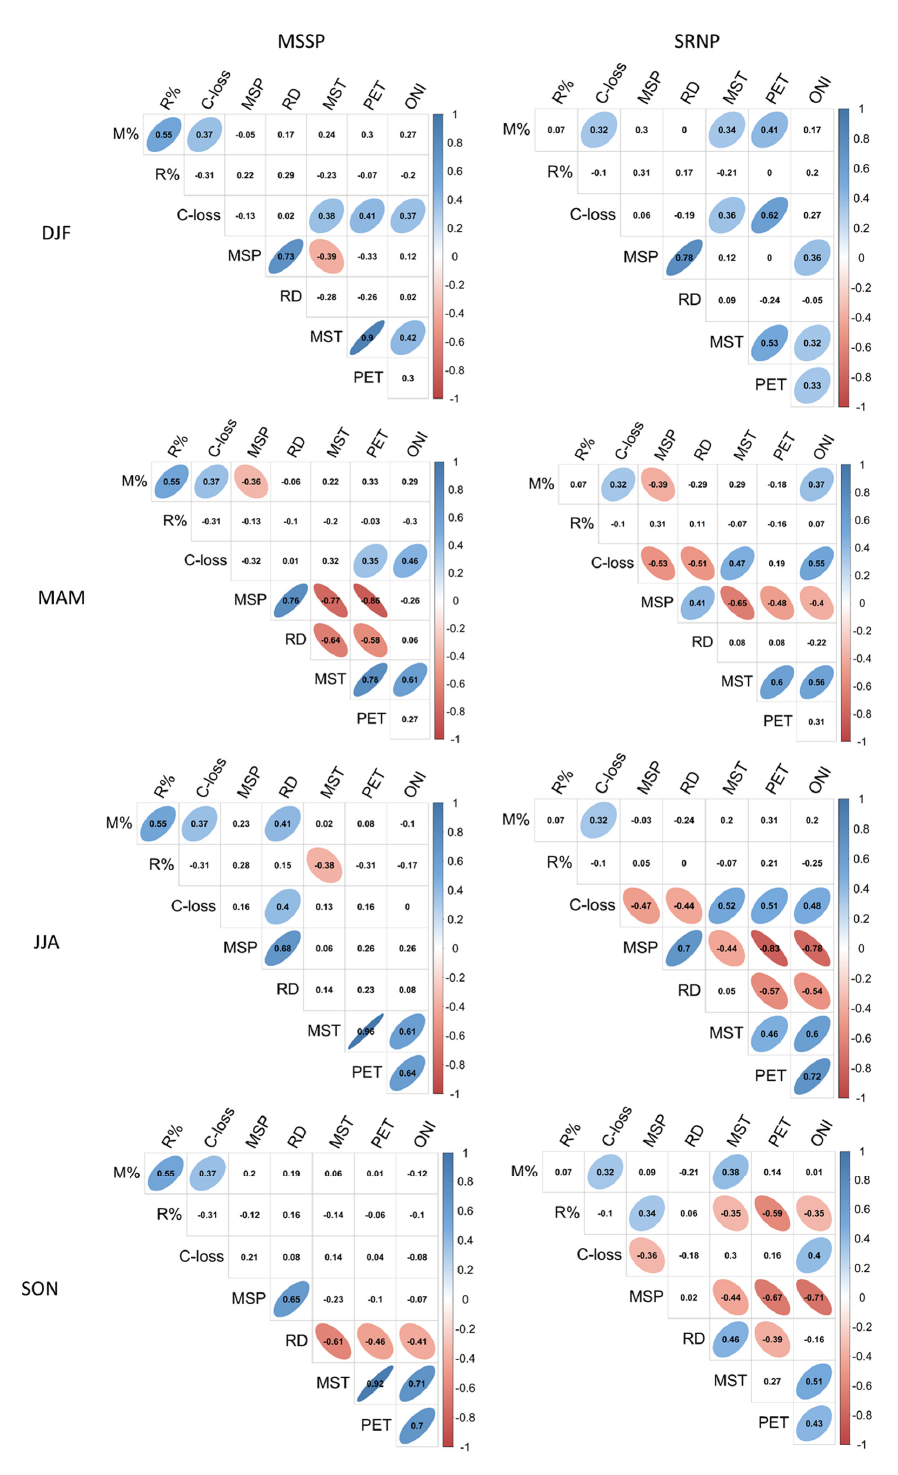
Figure 4. Pearson’s correlation coefficients for annual percentage of mortality (M%), annual percentage of recruitment (R%), annual carbon losses caused by mortality (C-loss), mean seasonal precipitation (MSP), mean seasonal temperature (MST), seasonal rainy days (RD), seasonal potential evapotranspiration (PET) and Oceanic El Nino Index (ONI) in Mata Seca State Park MSSP, and Santa Rosa National Park (SRNP). Only significant correlations ( p < 0.05) are shown in red or blue circles in the graph. DJF (December to February), MAM (March to May), JJA (June to August), SON (September to November), and DJF (December to